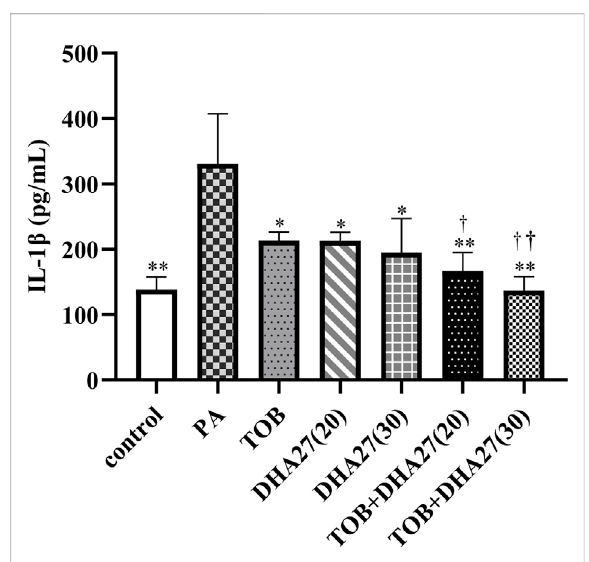
FIGURE 2 Effects of DHA27 combined with tobramycin (TOB) on the levels of interleukin (IL)-1 β in the spleen of sepsis model mice (mean±standarddeviation; n =4);DHA27(20):DHA2720 mg/kg/ d; DHA27 (30): DHA27 30 mg/kg/d; * p < 0.05, ** p < 0.01 vs. PA group; † p < 0.05, †† p < 0.01 vs. TOB